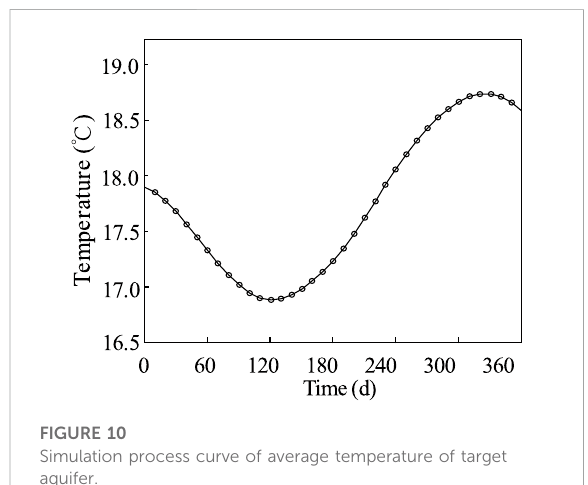
FIGURE 10 Simulation process curve of average temperature of target aquifer.